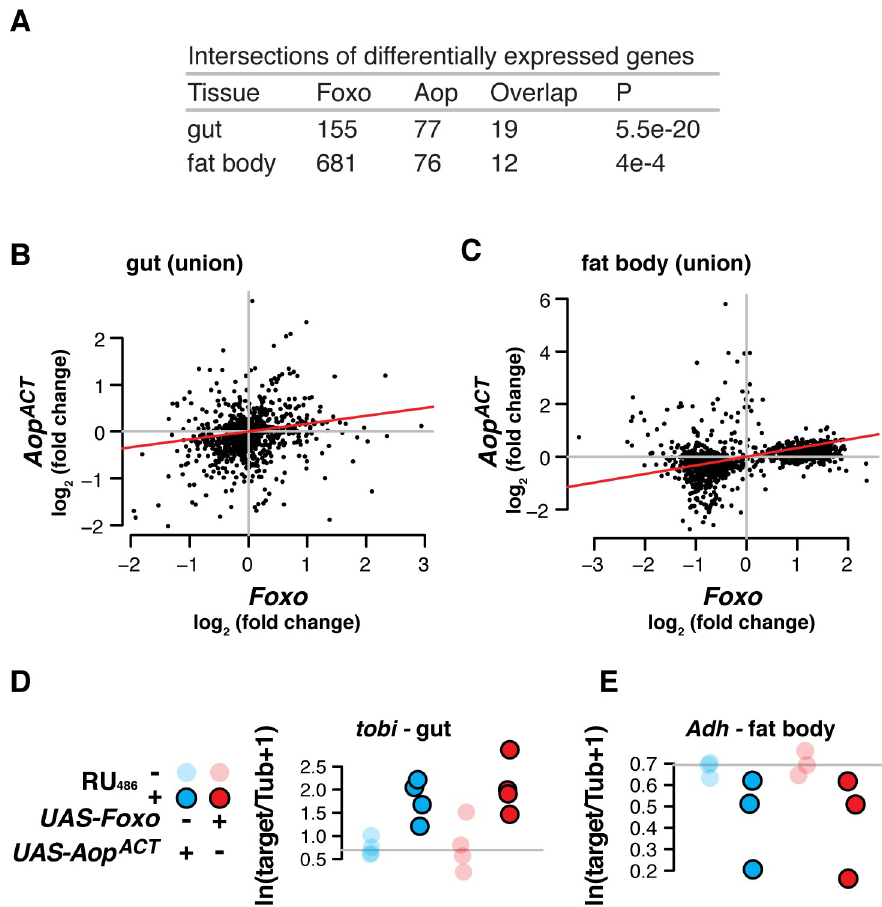
Fig 1. Aop recapitulates Foxo’s transcriptional output. (A) Transcriptomic analysis reveals that overexpression of either Foxo or Aop ACT under control of S 1 06 induces differential expression of an overlapping set of genes, in both gut and fat body. P values from hypergeometric tests. (B-C) In both gut and fat body, in the unions of sets of differentially expressed genes, transcriptomic effects of Aop ACT correlate those of Foxo (log 2 fold-change expression, calculated by DESeq2). Red lines show correlation coefficients (Kendall’s Tau, p < 10e-14 for both tissues). (D-E) qRT-PCR confirms congruent effects of Aop ACT and Foxo in fat body and gut (linear model: RU 486 p < 0.05 for either target, no effect of